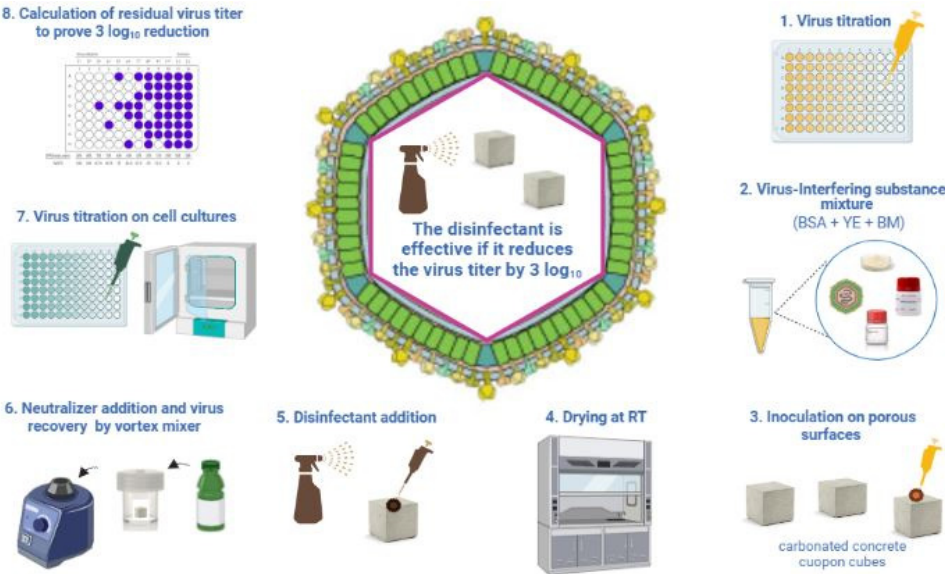
Figure 3. Test method applied to assess the virucidal activity of disinfectant on hard non-porous surfaces according to OECD guidelines adopted with slight modification by Gabbert et al. [39] for porous surfaces. Created in Biorender.com (https://biorender.com/), last accessed on 8 March 2022.